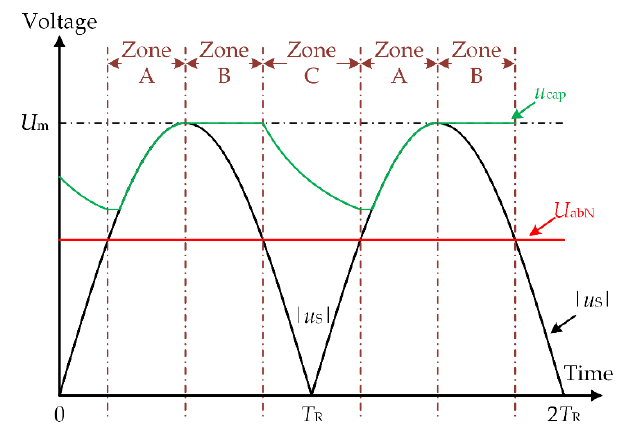
Figure 3. Waveforms of the capacitor voltage and the rectified mains supply voltage. Zone A: | u s | ≥ U abN and | u s | increase